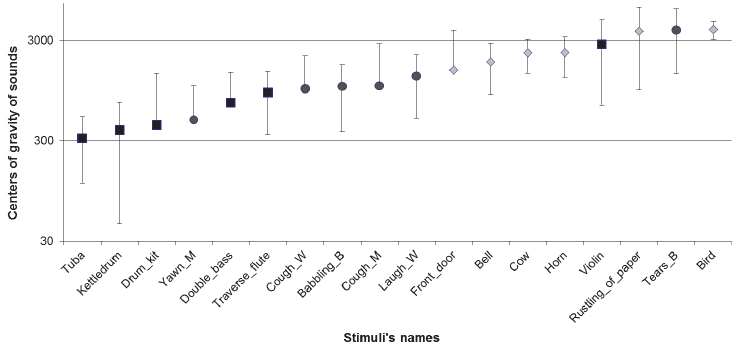
Fig 1. Distribution of the center of gravity of the sounds and frequency bands, ranging by frequency from low to high (scaled in log to base 10). Circles represent non-linguistic human vocalizations, square musical instruments, and diamond environmental